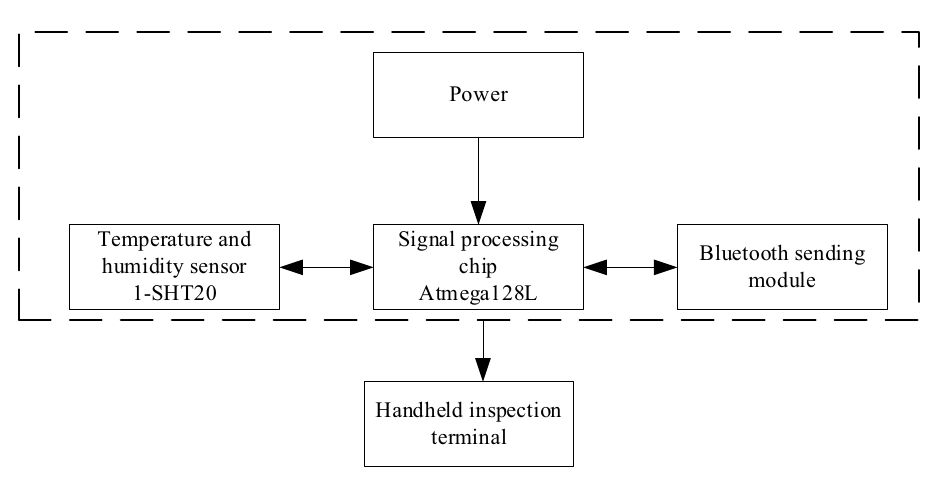
Figure 12. Block diagram of temperature and humidity